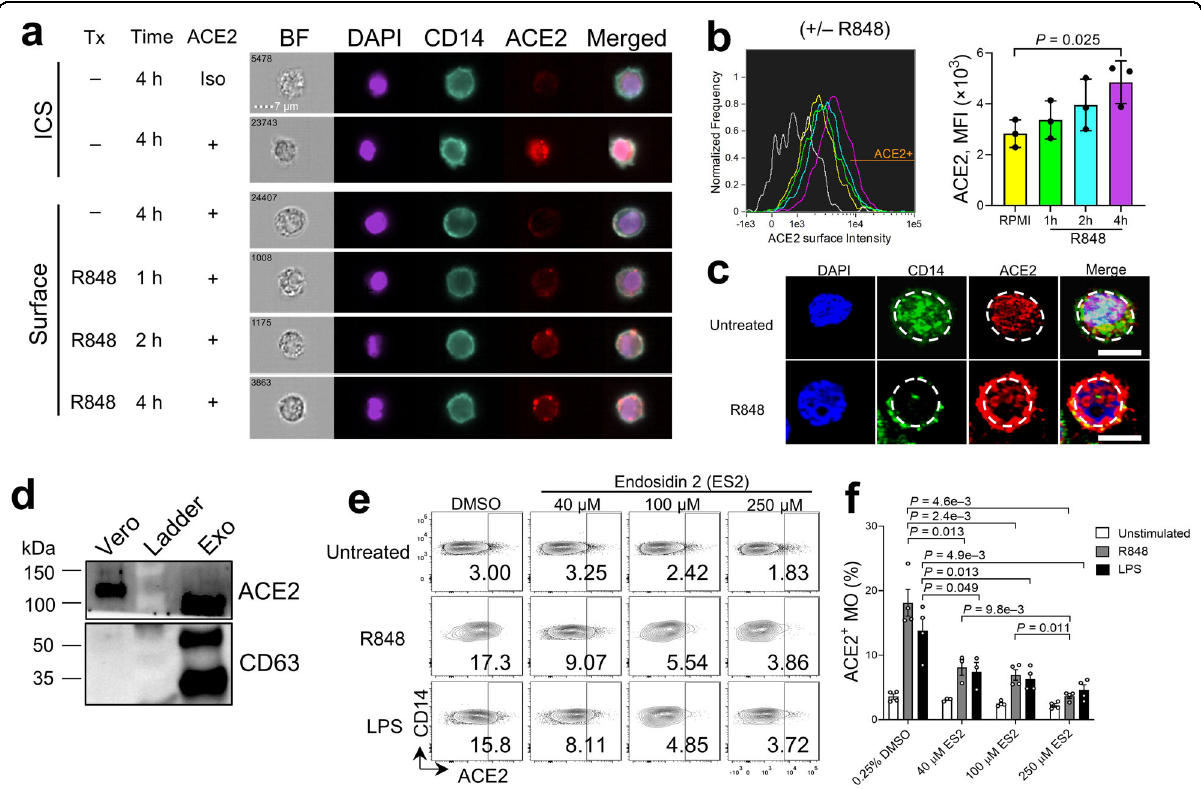
Fig. 2 Rapid translocation of cytoplasmic ACE2 to the cell surface of CD14 + monocytes after TLR activation. a Imaging fl ow cytometry analysis of cytoplasmic and surface ACE2 protein in CD14 + MO with or without R848 treatment up to 4 h. Each cell is represented by the row of images that include bright fi eld (BF), DAPI (purple), CD14 (turquoise), ACE2 (red), and the overlapping image merged with DAPI, CD14, and ACE2. b Histograms of ACE2 intensity on the cell surface of CD14 + monocytes treated with R848 (left). Grey line represents the isotype control group (Iso). Column graphs indicate MFI of ACE2 surface intensity at other indicated conditions (right) ( n = 3 biologically independent samples/group). c Representative confocal microscopy of ACE2 protein in CD14 + monocytes with or without R848 treatment for 24 h. Bars, 10 µm. Dashed lines show location of cell membrane. Images show cells from two healthy donors with similar results. d Immunoblot showing ACE2 and CD63 expression in exosomes isolated from plasma of healthy donors. The monkey kidney epithelial cell line Vero was used as a positive control. e Flow cytometry analysis of ACE2 surface expression in PBMCs pre-treated with the indicated concentrations of endosidin 2 (ES2) or DMSO for 1 – 2 h before ex vivo incubation with R484, LPS, or medium alone for 4 h. f Frequency of ACE2 + MO for data shown in e . Bars represent means ± SEM of biologically independent samples ( n = 3/group for 40 µM ES2 condition; n = 4/group for all other